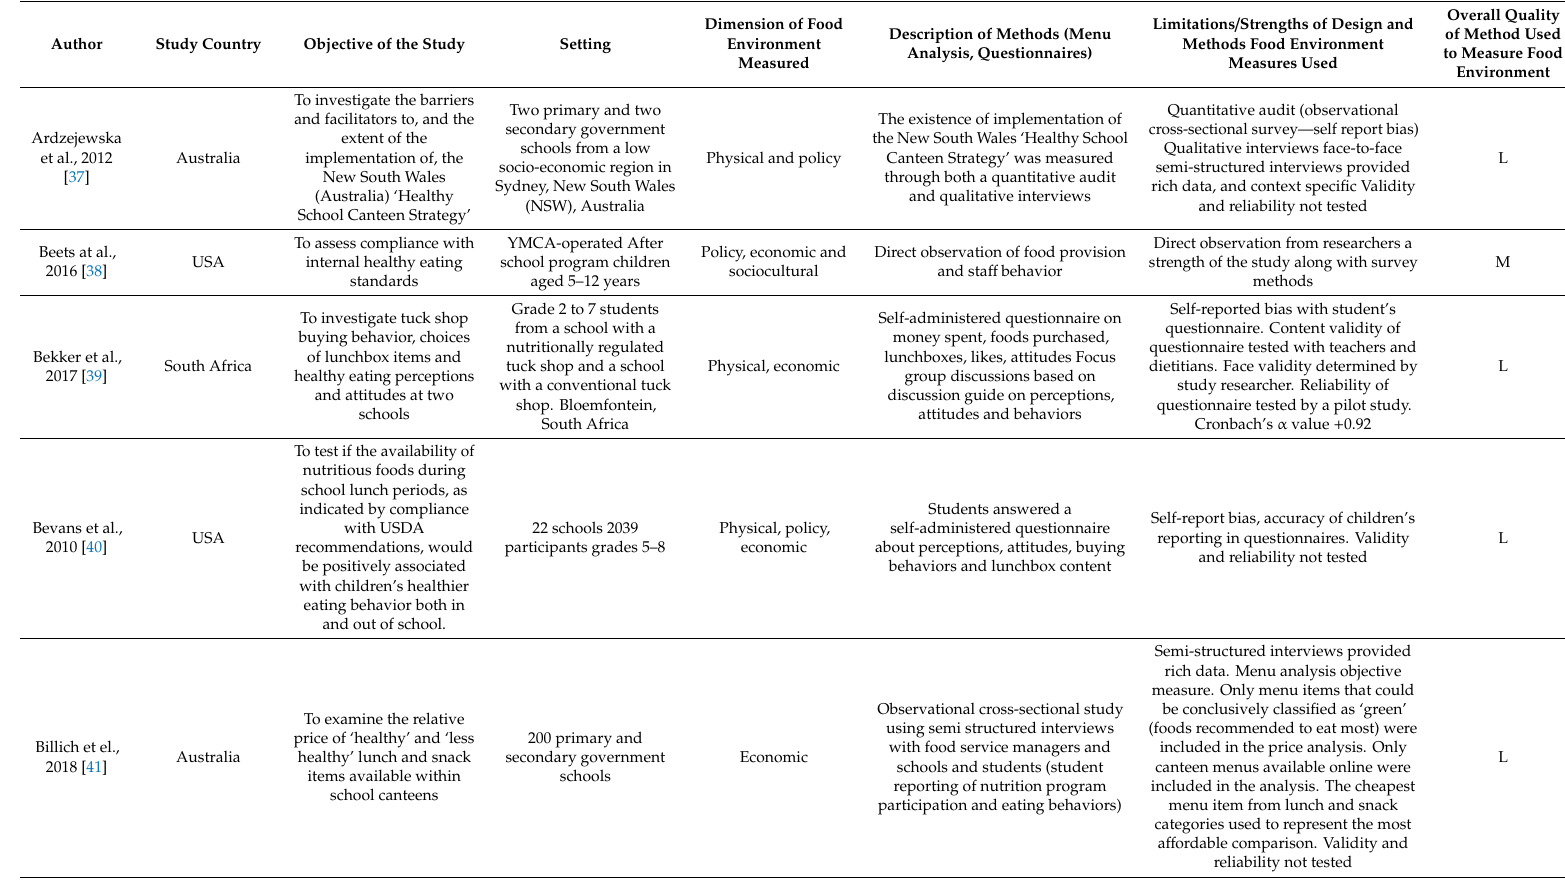
Table 2. Summary of identified studies measuring the school food